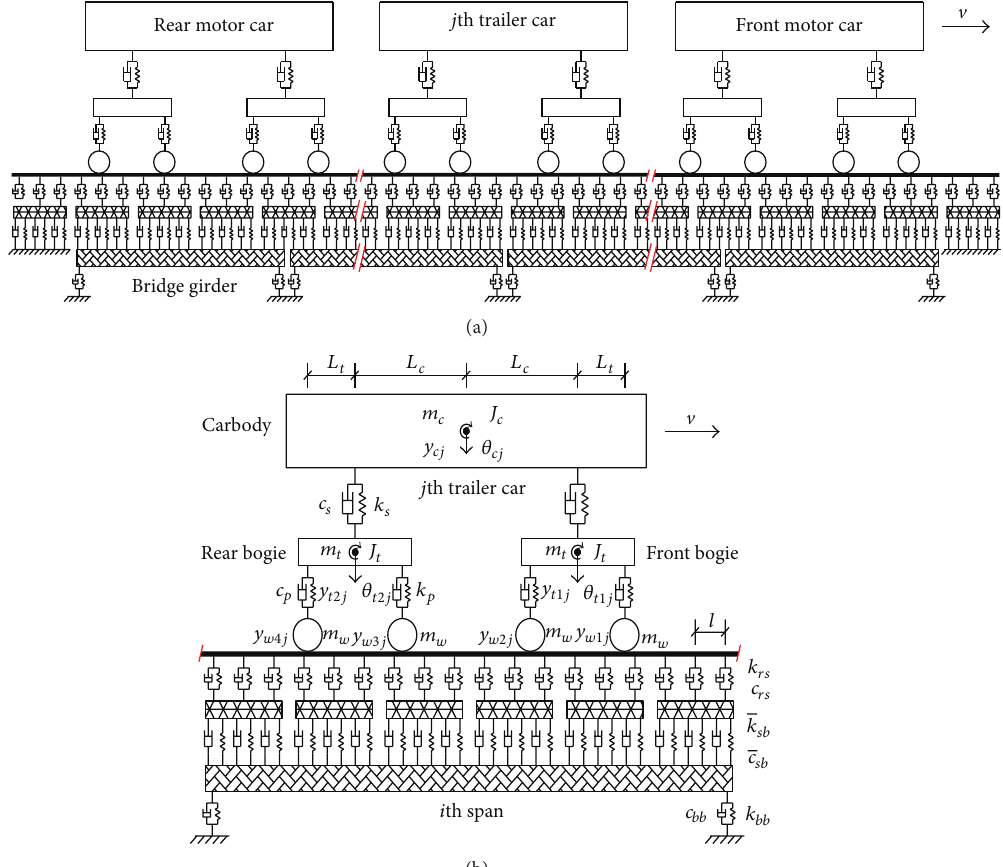
Figure 1: Model of train-slab track-bridge interaction system. (a) A train moving upon a slab track resting on a multispan simply supported beam bridge. (b) The 𝑗 th trailer car moving upon the 𝑖 th span simply supported beam. of the fastener are represented by discrete massless springs with stiffness 𝑘 𝑟𝑠 and dampers with damping coefficient 𝑐 𝑟𝑠